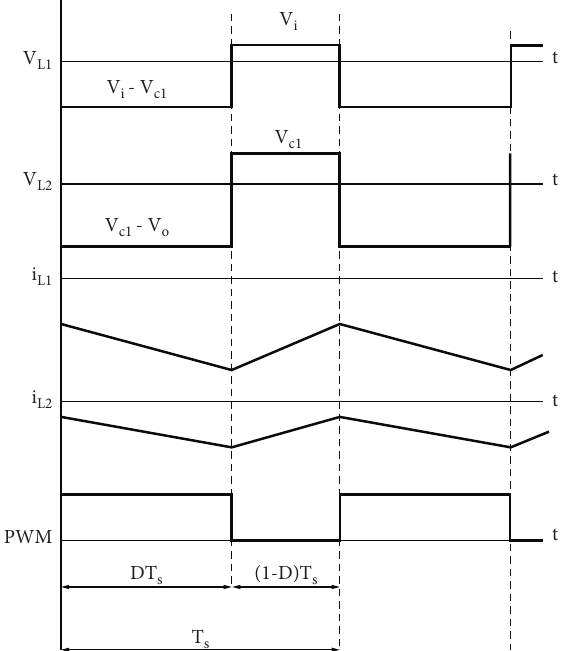
Figure 8: Converter’s voltage and current waveform in buck mode.